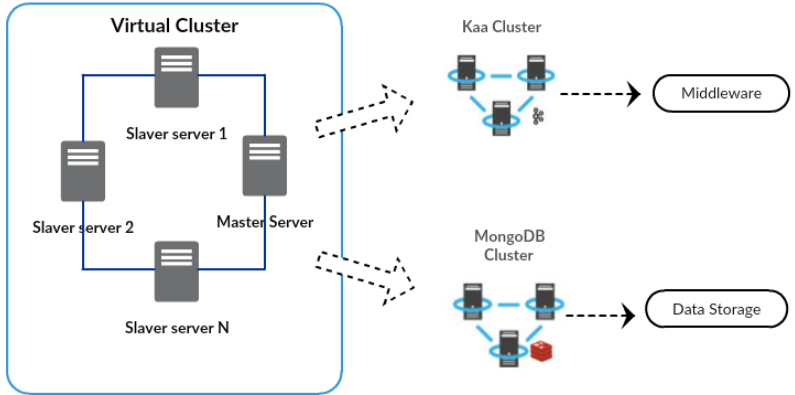
Figure 10. Computational environment of DDS.